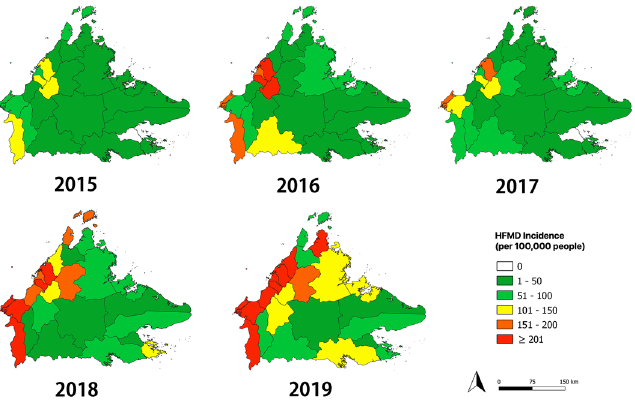
Figure 2. Annual spatial trend of hand, foot, and mouth disease across the 25 districts in Sabah from 2015 to 2019. The maps were generated using QGIS version 3.14.1 Pi (https:// www. qgis.